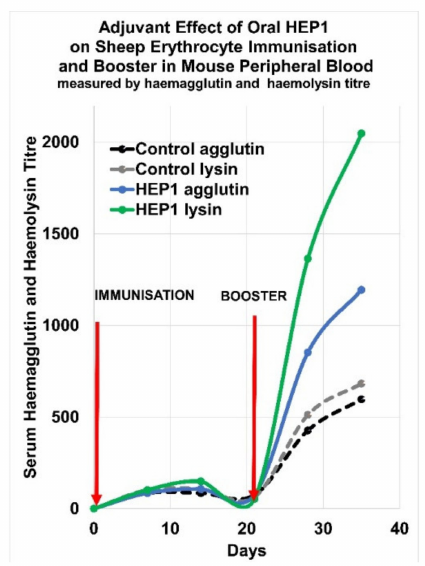
Figure 9. Adjuvant effect of oral HEP1 pre-treatment during 20 days prior to immunisation (Day 1) and booster (Day 21) immunisation with 20 million sheep erythrocyte (SE cells) in mice, measured by serum haemaglutin and haemolysin titre and compared to control mice with no oral HEP1 pre-treatment plotted in